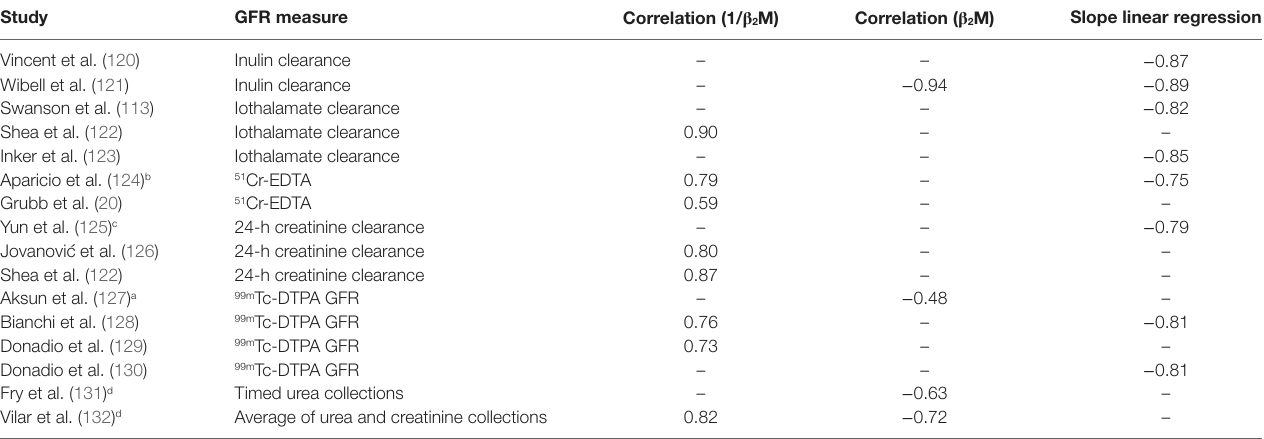
TABLe 1 | Relationship between beta-2 microglobulin ( β 2 M) and glomerular filtration rate (GFR) in